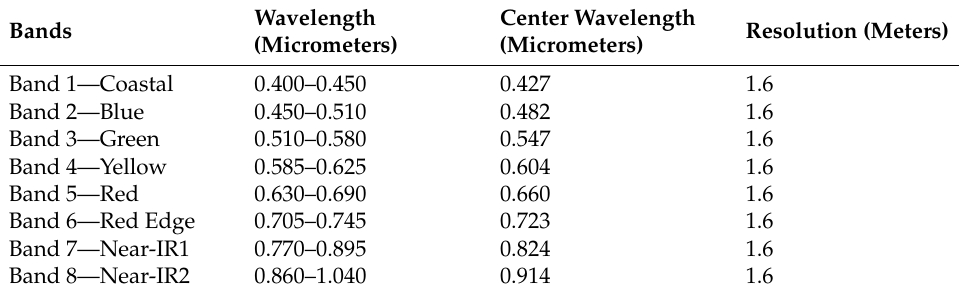
Figure 2. WV3 image acquired on the study area. Table 3. Worldview 3 spectral